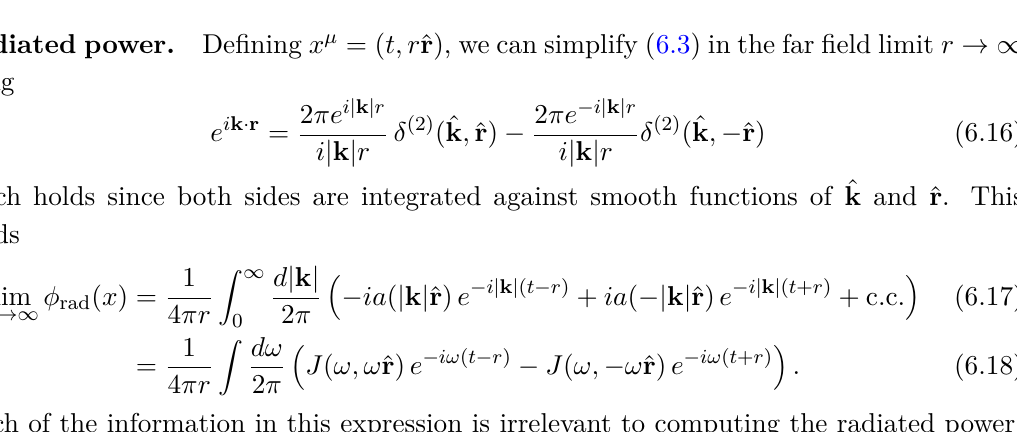
Figure 3 . The field φ of a kicked particle has outgoing radiation on the forward light cone, the final static field F 0 inside, and the initial static field F outside. Subtracting off the advanced field φ a gives a pure radiation field, which has incoming radiation on the backward light cone, outgoing radiation on the forward light cone, and the difference F − F 0 outside both light